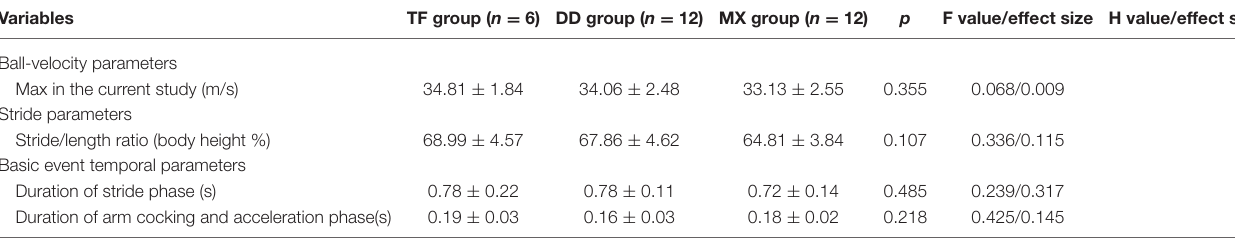
TABLE 2 | Comparison of ball velocity, stride, and temporal parameters among the three stride types. Variables